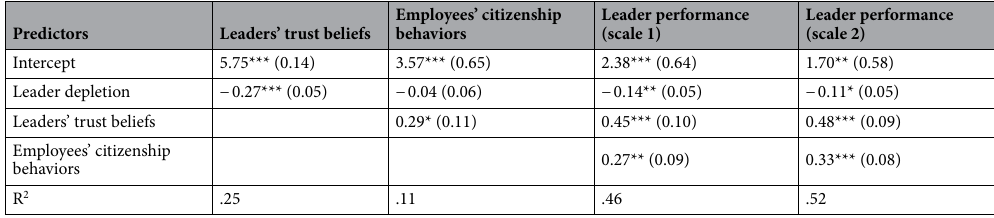
Table 2. Results of the regression analyses (Study 1). Values reflect b with SE between parentheses. * p < .05. ** p < .01. *** p <